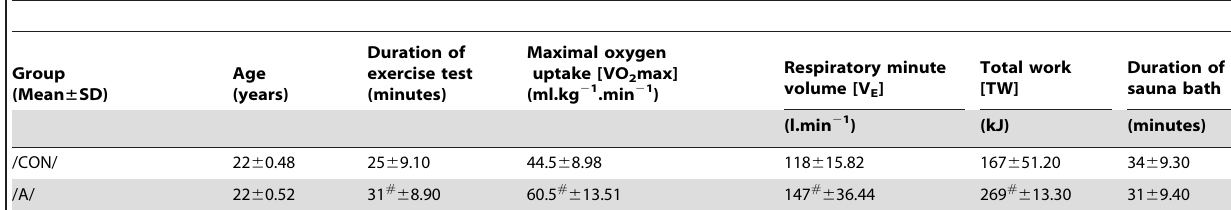
Table 1. Participants’ age, duration of exercise test, total work, maximal oxygen uptake, respiratory minute volume and duration of sauna bathing session in untrained men (CON) and athletes